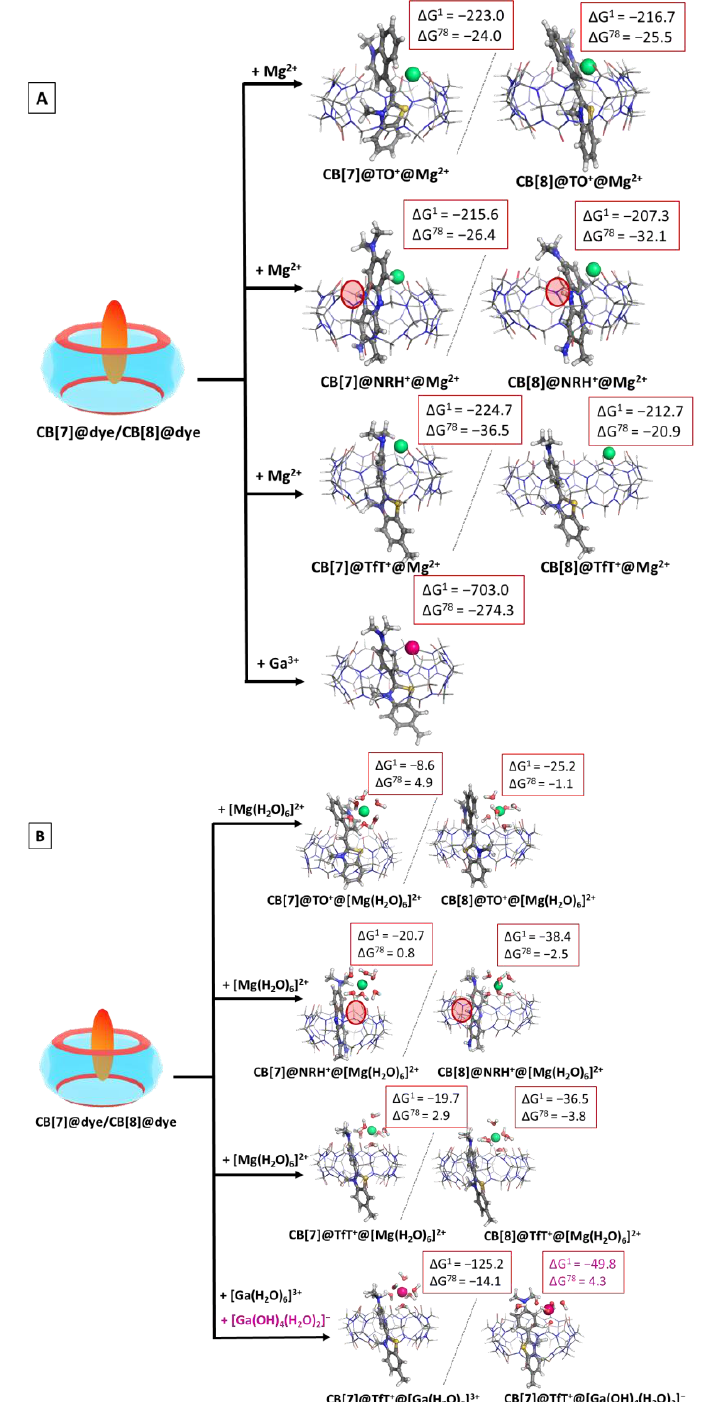
Figure 5. M062X/6 − 31G(d,p) optimized structures of the CB[7/8]@dye@metal complexes in the Figure 5. M062X/6 −3 1G(d,p) optimized structures of the CB[7/8]@dye@metal complexes in the gas phase and the corresponding ∆G ε values in kcal mol −1 for their formation in the gas phase ( ε=1 ), and gas phase and the corresponding ∆ G ε values in kcal mol − 1 for their formation in the gas phase water ( ε=78 ) at the M062X/6 −3 1+G(d,p)//M062X/6 −3 1G(d,p) level of theory by cooperatively binding ( ε = 1), and water ( ε = 78) at the M062X/6 − 31+G(d,p)//M062X/6 − 31G(d,p) level of theory by the metal to the already formed CB[7/8]@dye complex. The results are obtained by considering the cooperatively binding the metal to the already formed CB[7/8]@dye complex. The results are bare ( A ) and hydrated ( B ) metal cation. The hydration shell around gallium(III) is modelled as obtained by considering the bare ( A ) and hydrated ( B ) metal cation. The hydration shell around [Ga(H 2 O) 6 ] 3+ / [Ga(OH) 4 (H 2 O) 2 ] - in correspondence with the pK a values of the metal. gallium(III) is modelled as [Ga(H 2 O) 6 ] 3+ / [Ga(OH) 4 (H 2 O) 2 ] − in correspondence with the pK a values of the